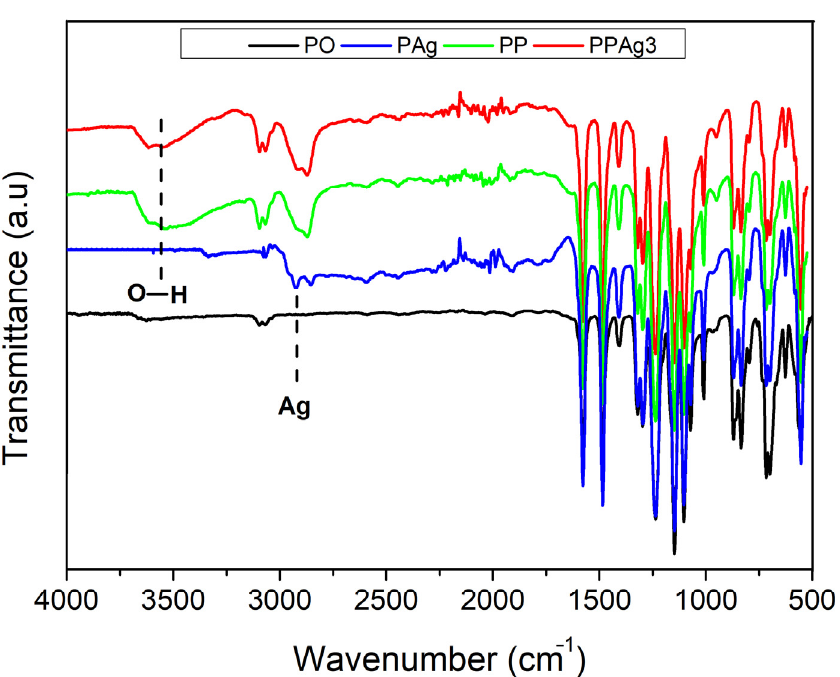
Figure 4. FTIR analysis of the membranes’ surface.